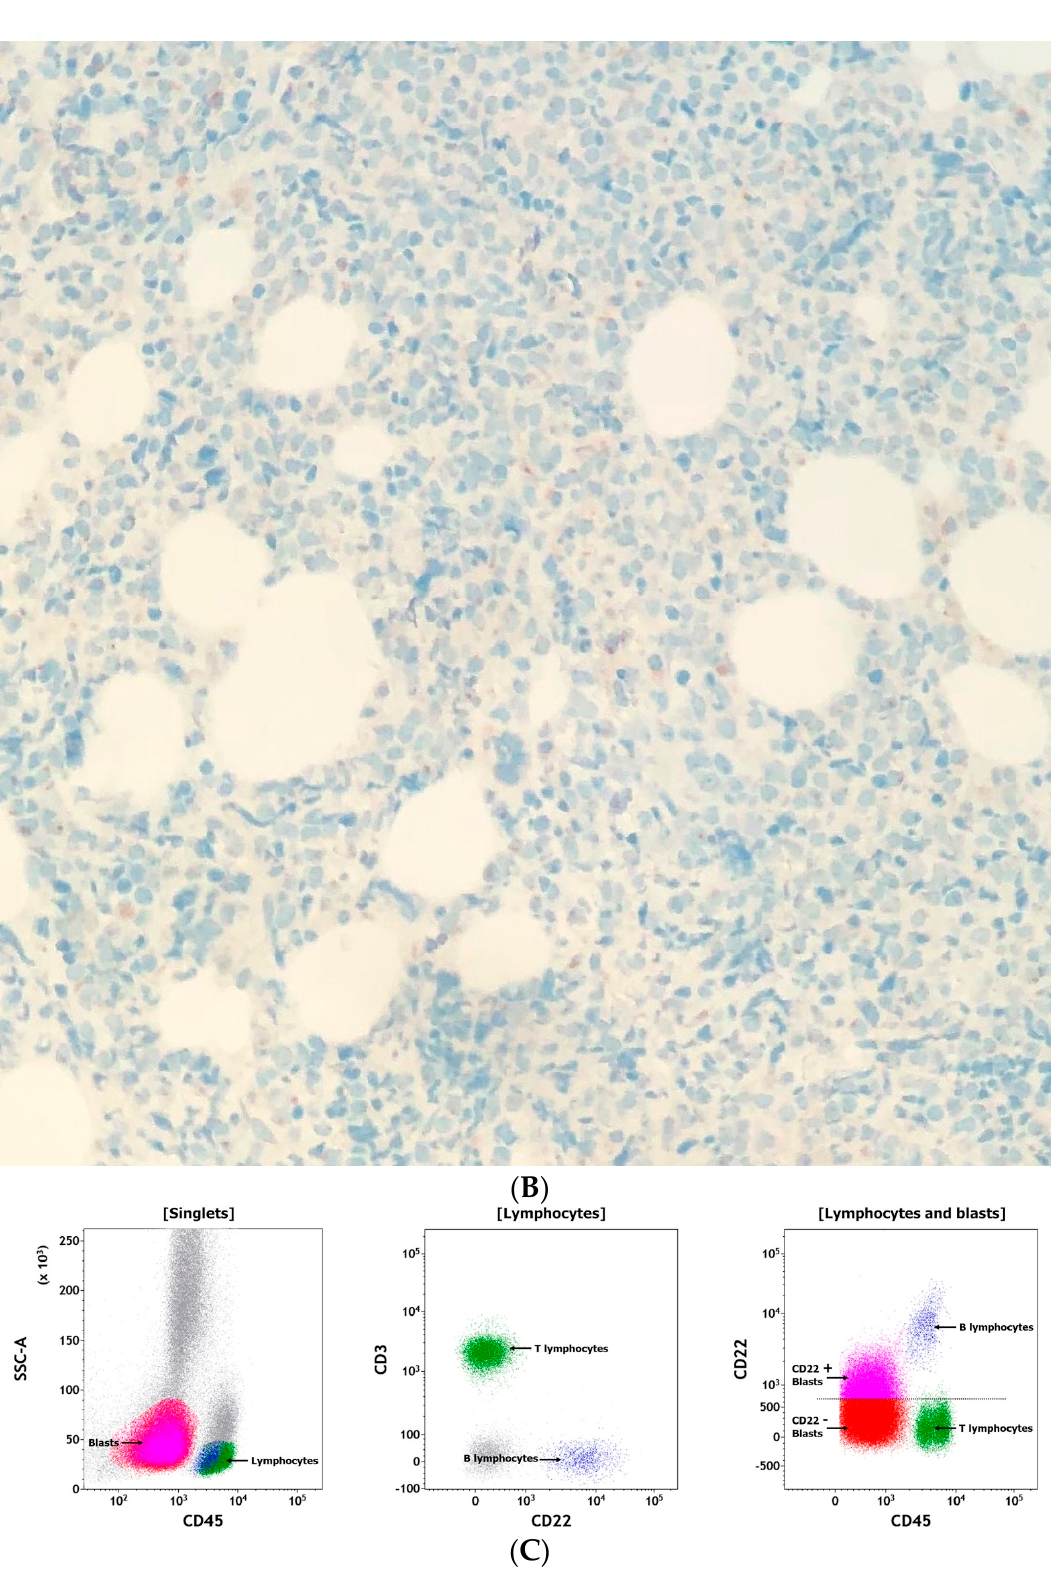
Figure 1. ( A ) Representative photomicrograph of the bone marrow biopsy diagnostic for relapse of B-ALL in the outlined patient case. The marrow space is packed by sheets of medium sized blasts and few interspersed hematopoietic cells (hematoxylin and eosin stain, 40× objective). ( B ) Representative photomicrograph of the immunohistochemical stain of marrow for CD22 in the outlined patient case (CD22 positive cells stain brown; 40× objective). ( C ) Flow cytometry of peripheral blood at time of relapse of B-cell acute lymphoblastic leukemia (gated populations displayed are indicated above panels). Left panel: CD45 versus side scatter plot showing CD45-dim blasts and CD45-bright